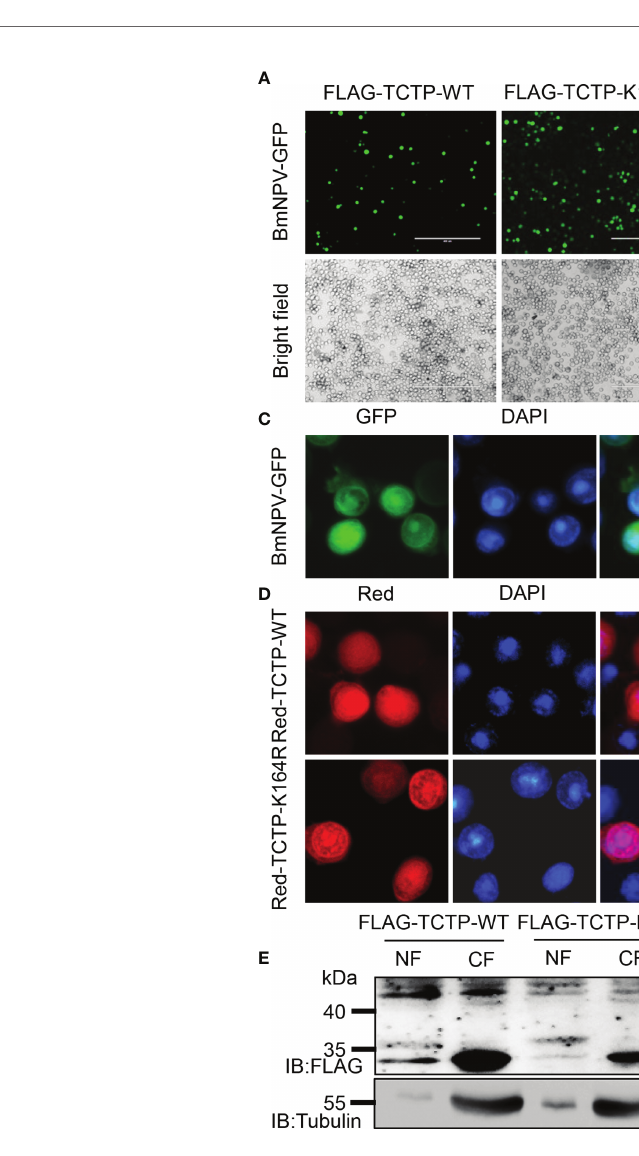
FIGURE 3 | De fi ciency of Bombyx mori translationally controlled tumor protein ( BmTCTP ) SUMOylation affected its antiviral immunity. (A) Plasmids as indicated were transfected into the silkworm BmN cells, and then cells were infected with Bombyx mori nucleopolyhedrovirus (BmNPV)-GFP for 72 h. Fluorescence microscopy was used to observe the viral amounts. Scale bar, 400 m m. (B) The viral DNA contents were detected by qRT-PCR analysis of the BmNPV GP41 gene. The expression of BmGAPDH gene was used as an internal control. The data presented are the means ± SD (n = 3). For the signi fi cant analysis: **P < 0.01. (C) BmN cells were infected with BmNPV-GFP for 72 h. BmNPV-positive cells were then determined by fl uorescence (green), and the nuclear DNA was counterstained with 4 ’ ,6-diamidino-2- phenylindole (DAPI) (blue). Scale bar, 10 m m. (D) Red-TCTP-WT or Red-TCTP-K164R plasmid was transfected into the silkworm BmN cells, and then cells were infected with BmNPV-GFP for 72 h. Subcellular localization of Red-TCTP-WT or Red-TCTP-K164R in BmNPV-positive cells were determined by fl uorescence (red), and the nuclear DNA was counterstained with DAPI (blue). Scale bar, 10 m m. (E) Cytoplasm (CF) and nuclear (NF) fractions isolated from BmNPV-GFP-infected cells